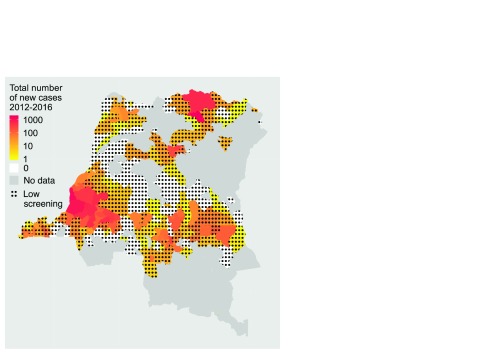
Geographic availability of gambiense human African trypanosomiases (gHAT) data across the Democratic Republic of the Congo.Colours represent numbers of reported cases in health zones from the last five years of data set. Health zones that never (2000–2016) report cases or active screening are coloured grey, whilst zones with <5% mean active screening coverage (during 2012–2016) are shown with black dots. This figure has been adapted from data presented in Franco
et al.
1 under a CC-BY 4.0 license and with permission from Dr Erick Mwamba Miaka, director of the National HAT Control Programme (PNLTHA) of the Democratic Republic of the Congo.